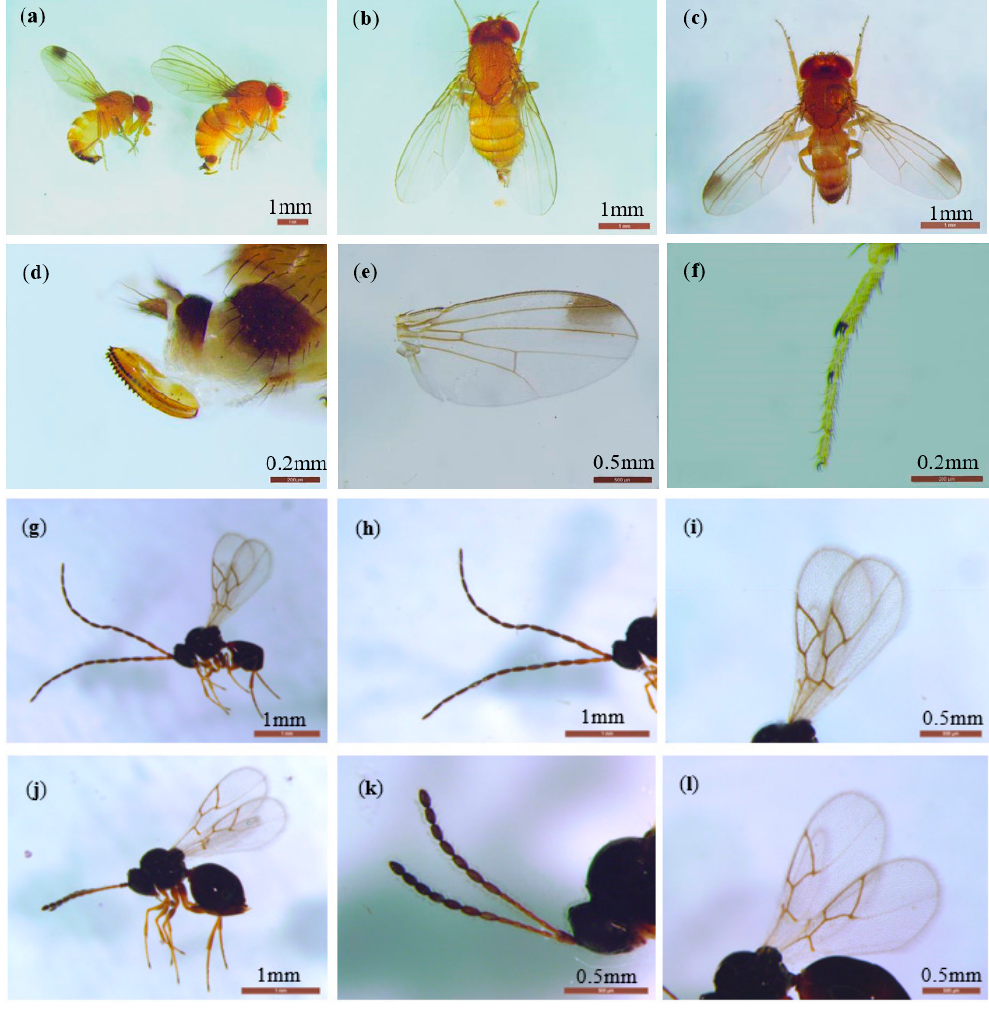
Figure 1. Morphological identification of D. suzukii adults, L. japonica adults, and A. japonica adults. ( a – f ): D. suzukii adult. ( a ) adult male and female (relative body size), ( b ) adult female, ( c ) adult male, ( d ) female ovipositor, ( e ) male wing with a black spot, ( f ) the sexual combs on male’s fore tarsi. ( g – l ): L. japonica adult. ( g ) male adult, ( h ) male antennae (15 segments), ( i ) male forewings, ( j ) female adult, ( k ) female antennae (13 segments), ( l ) female forewings. ( m – r ): A. japonica adult. ( m ) female adult, ( n ) female antennae, ( o ) female forewings, ( p ) the dorsum of female, ( q ) the mesosoma and metasoma of female, ( r ) female ovipositor. 3.2. Captures of Adult D. suzukii in Sentinel Traps A total of 406 traps were deployed and successfully recovered from four different locations, and D. suzukii adults were found in all locations. In total, 11,229 adults of D. suzukii (6697 females and 4532 males) and 34,743 adults of other Drosophila species were captured. Different adult Drosophila species were captured from survey locations, and D. mela- nogaster Meigen was the most abundant species. The relative abundance (RA) of D. suzukii adults was less than 30% at all survey locations. The RAs of D. suzukii adults captured were 5.61%, 28.89%, 26.91%, and 18.10% from WFD, FK, FC, and SY, respectively (Figure 2, Supplementary Data S1). The RAs of D. suzukii adults captured from FK and FC were significantly higher than those from WFD and SY (F = 7.720, df = 3, 37, p < 0.05).